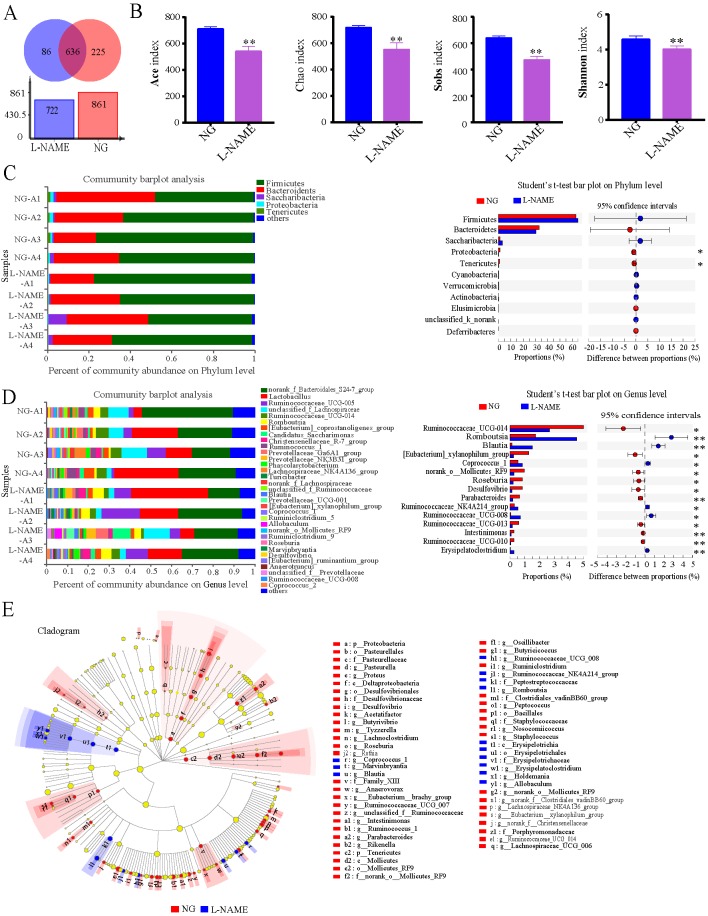
Gut microbiota dysbiosis in the L-NAME-treated rats. (A) The level of Operational Taxonomic Units (OTU). (B) Ace index, Chao index, Sobs index, and Shannon index of Alpha diversity analysis. (C, D) Percent of community abundance on Phylum and Genus levels, and relative abundances of differential bacteria analyzed by the Student’s t-test. (E) The taxonomic groups identified using the linear discriminant analysis effect size (LEfSe). The data were expressed as means ± SEM. Significant differences are indicated by *P < 0.05, **P < 0.01 as compared with the NG (n = 4 per group).